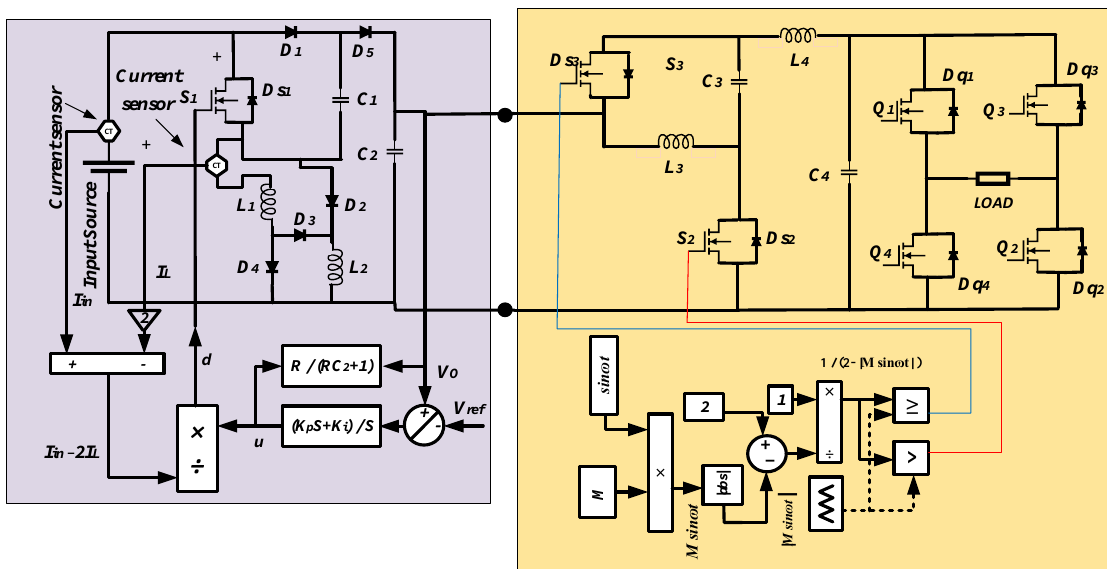
Figure 2. The proposed converter and its controller.